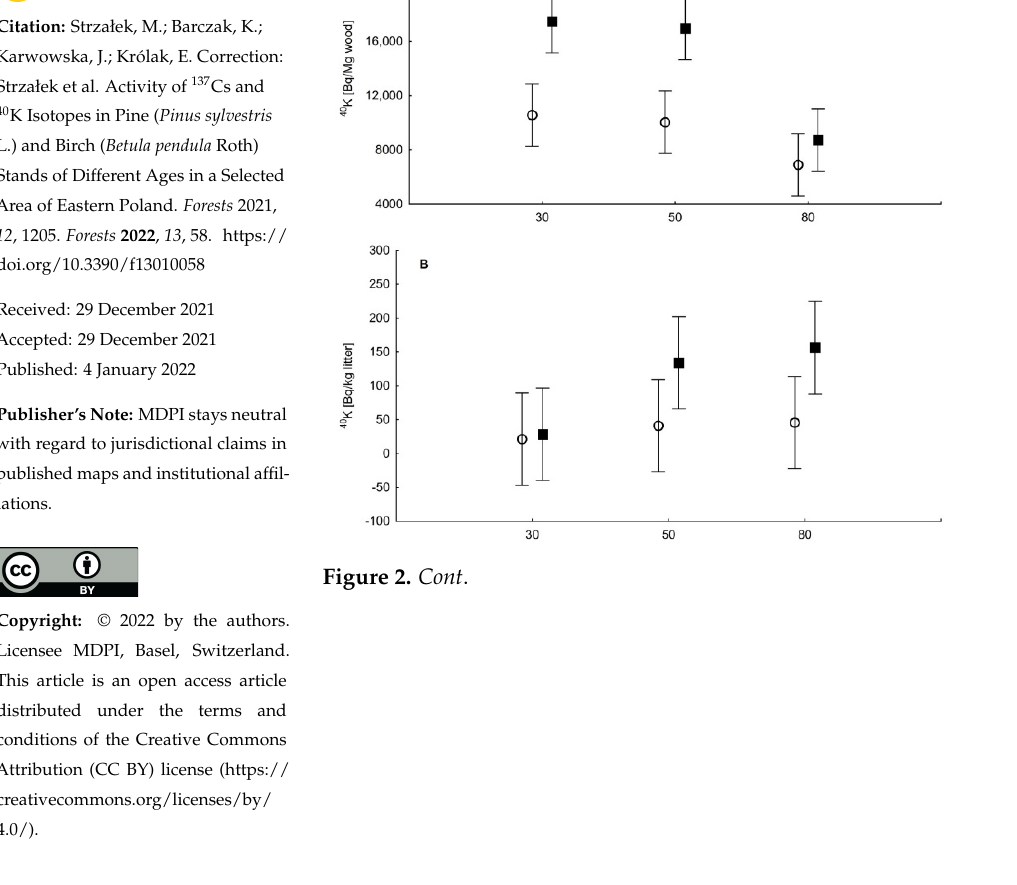
Figure 2. Activity of 40 K in wood ( A ), litter ( B ), and soil ( C ) in pine (P) and birch (B) stands of dif- ferent ages (mean ± confidence level).